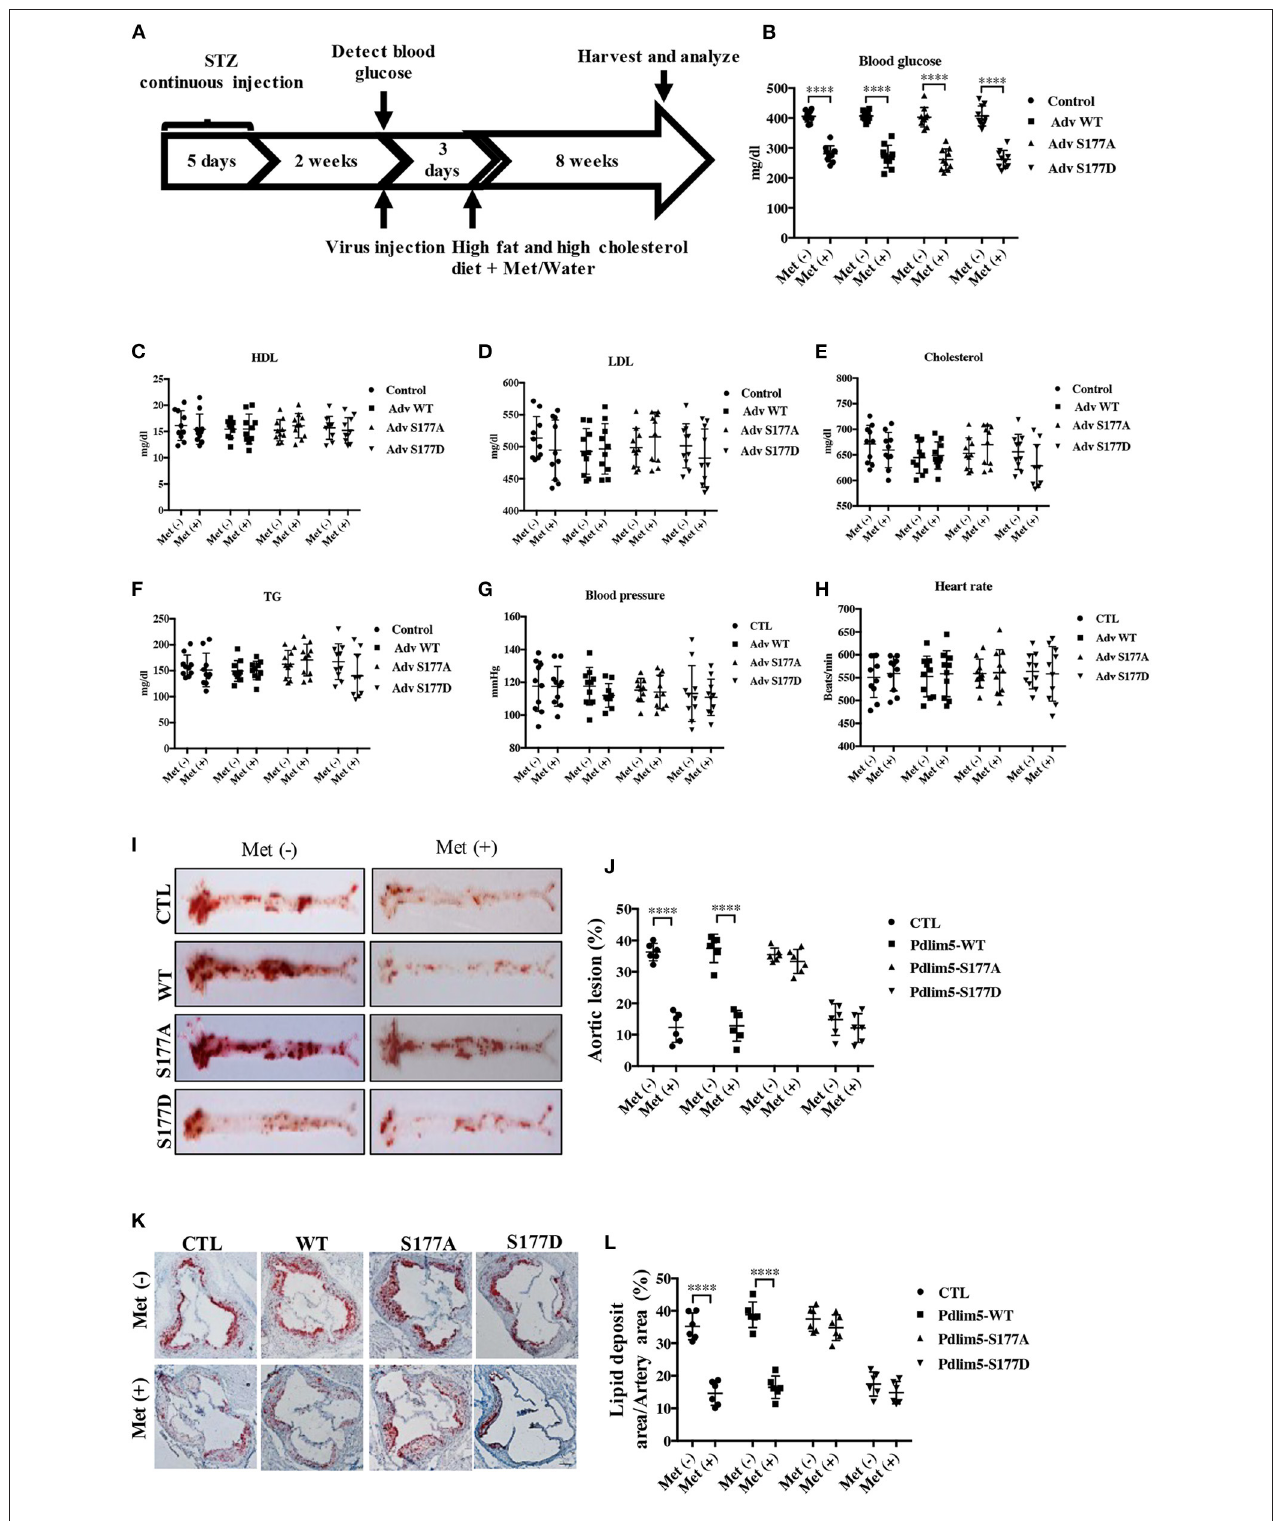
FIGURE 4 | Phosphorylation of Pdlim5 is involved in the anti-atherosclerosis function of metformin in diabetic ApoE − / − mice. The ApoE − / − mice had induced diabetic atherosclerosis and intervened with metformin as described in “Materials and Methods” for 8 weeks ( n = 10 per group). At the same time, the mice were